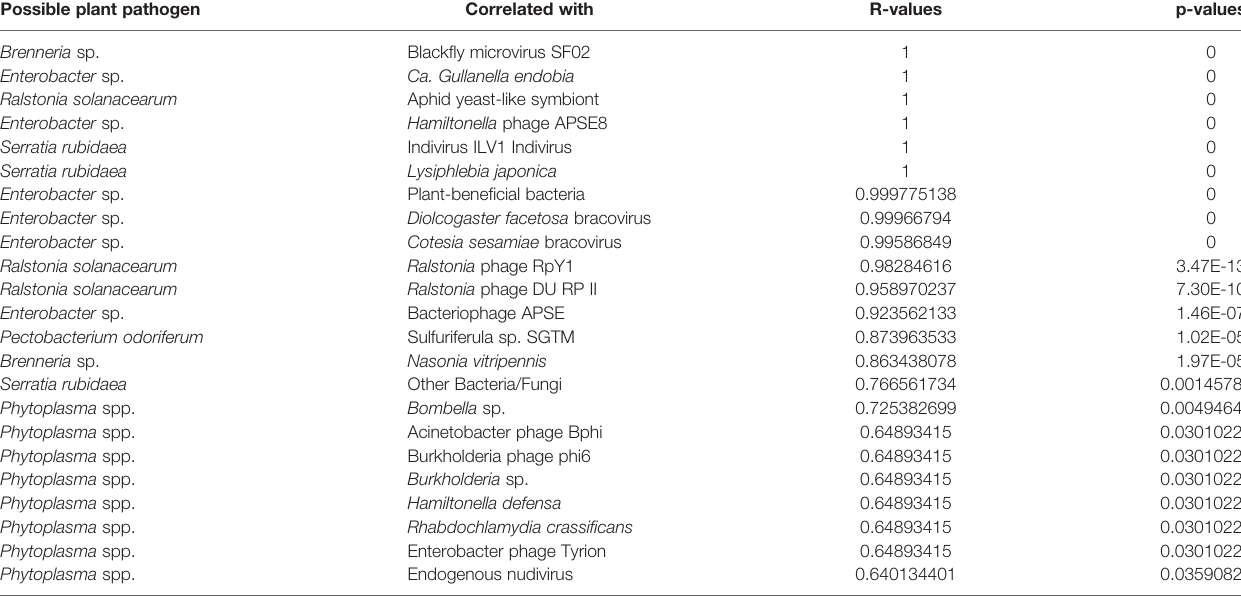
TABLE 2 | Statistically signi fi cant correlations between relative abundances of putative plant-pathogens (classi fi ed based on predominant function of closest blast hit) and other organisms and viruses in membracids. Possible plant pathogen Correlated with R-values p-values Brenneria